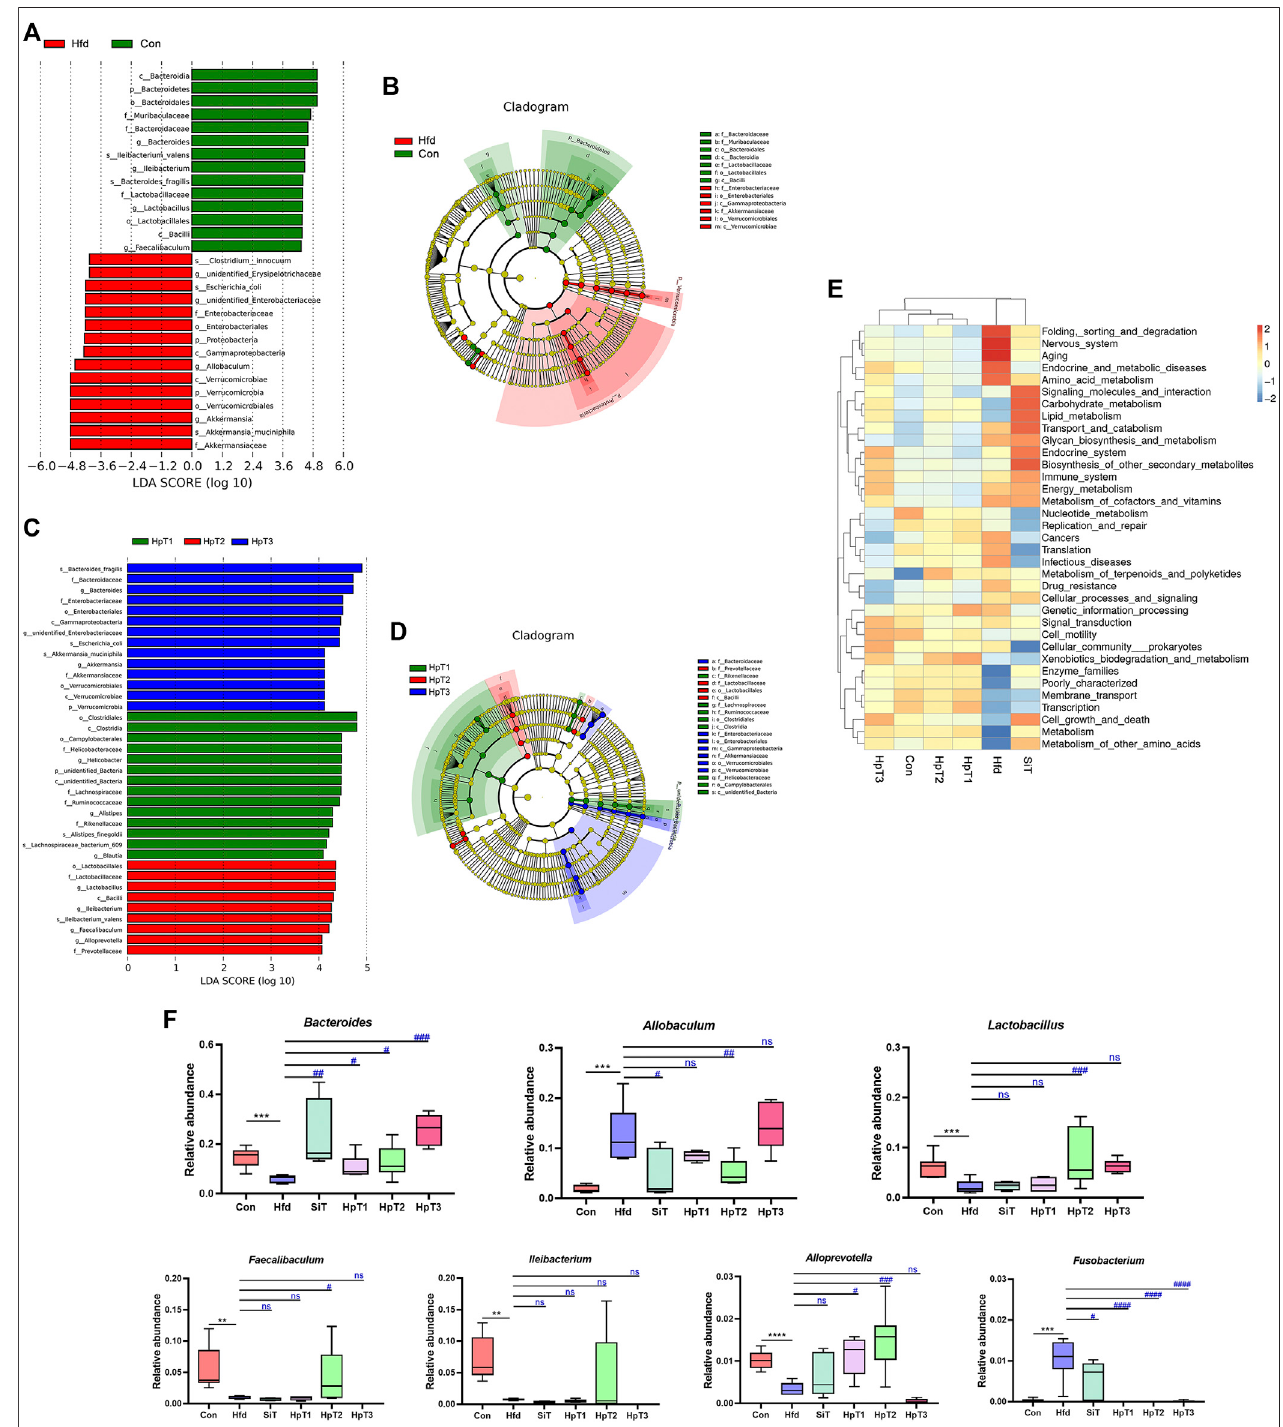
FIGURE 4 | Comparison of differential microbial abundance, characteristic taxa and predicted functions from different mice groups. (A) Histogram of taxa with differential abundance in Con and Hfd groups using computed LDA scores. The LDA scores represent the degree of difference abundance in characteristic microbial communities between Con and Hfd groups. (B) Circular cladogram of statistically and biologically differences in fecal samples between Con and Hfd groups. Each of circle diameter was proportional to theabundance oftaxon.Green (cid:2) taxon signi fi cantly enriched inCon, red (cid:2) taxonsigni fi cantlyenriched in Hfd and yellow (cid:2) non- signi fi cant. (C) Histogram oftaxa with differential abundance among HpT1, HpT2 and HpT3 groups using computedLDA scores. The LDA scores represent thedegree ofdifferenceabundanceincharacteristicmicrobialcommunitiesamongHpT1,HpT2andHpT3groups. (D) Circularcladogramofstatisticallyandbiologicallydifferences